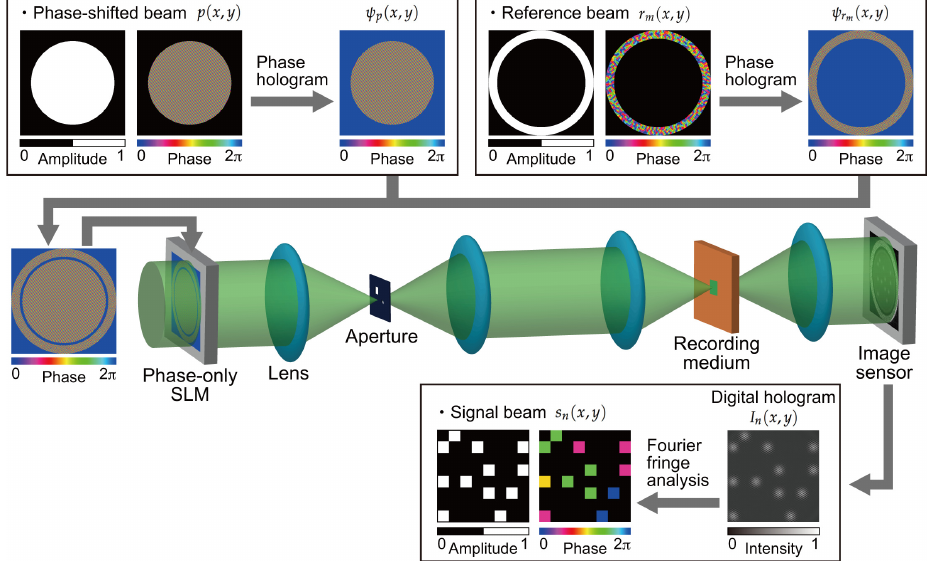
Figure 2. Retrieving process in a holographic storage system using digital holographic